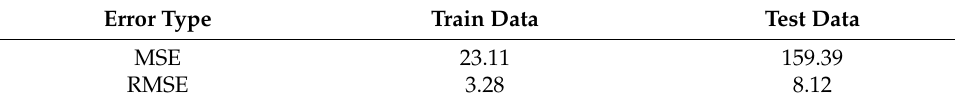
Table 6. Performance of the random forest algorithm in training and test datasets.